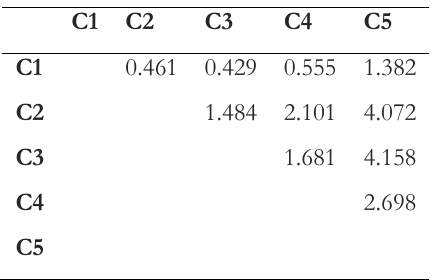
Table 2. Pairwise comparisons of the main